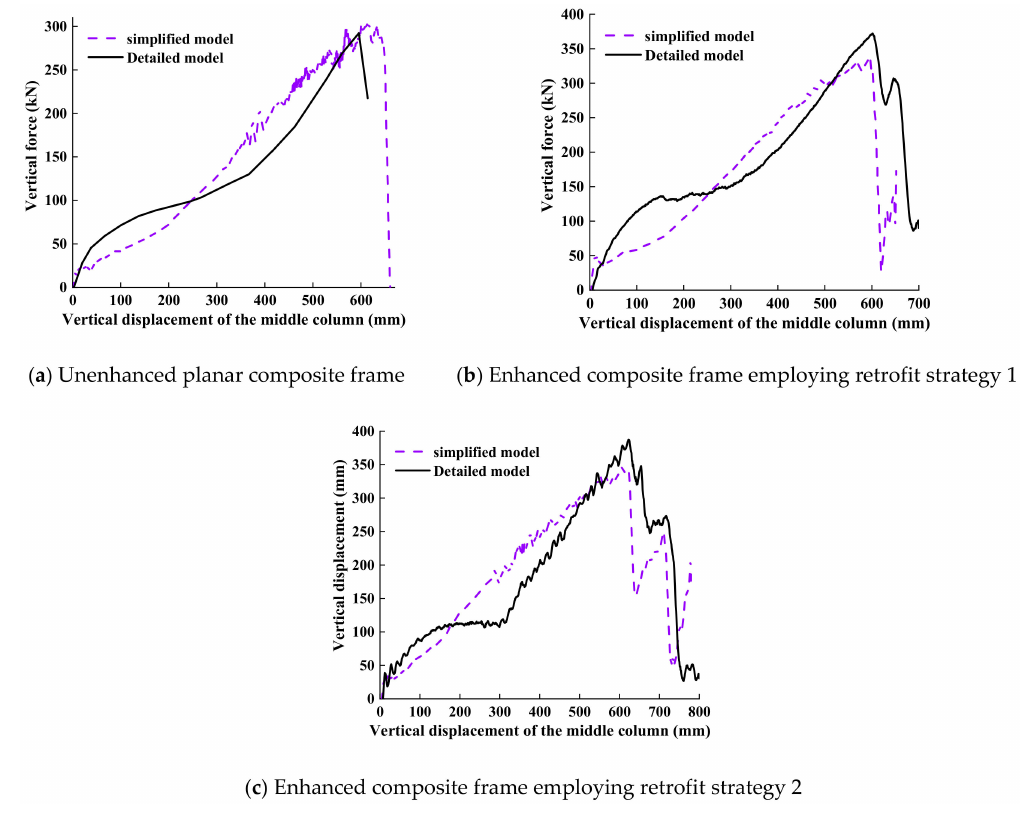
Figure 26. Comparisons between detailed models and simplified